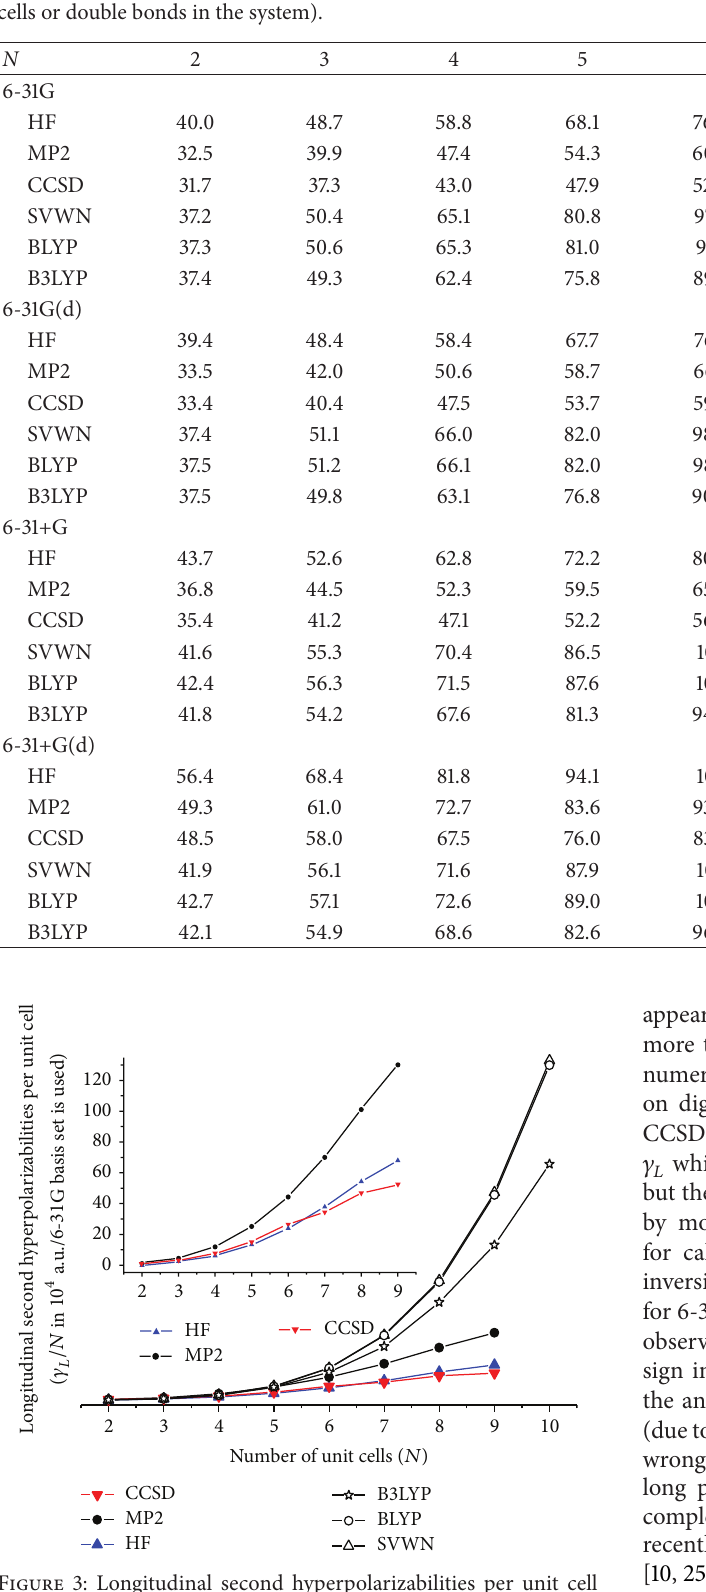
Figure 3: Longitudinal second hyperpolarizabilities per unit cell /𝑁) of polyenes (in 10 4 a.u.) obtained by various quantum (𝛾 𝐿 chemical methods with 6-31G basis